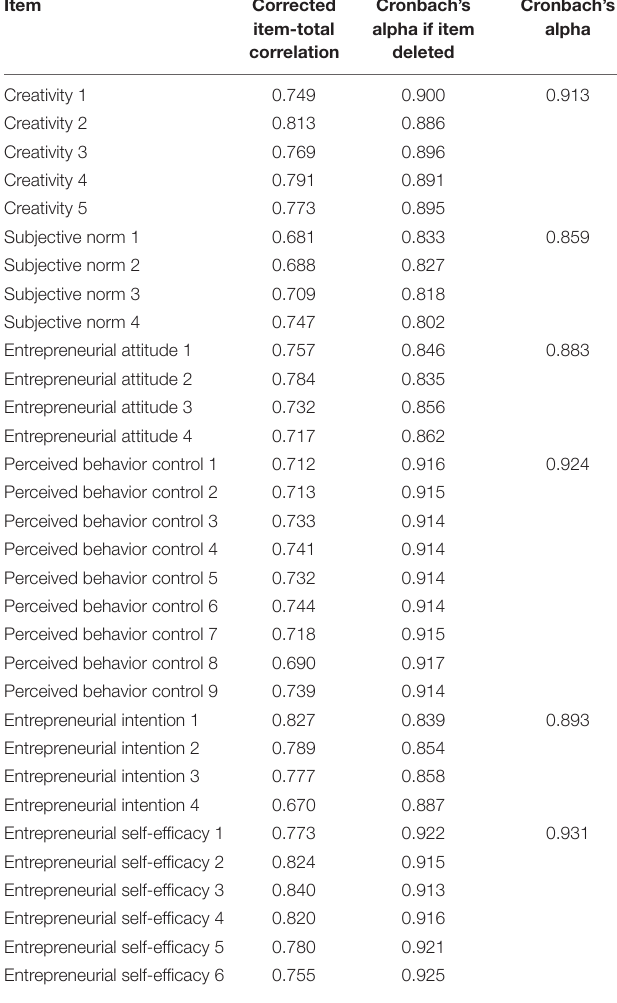
TABLE 1 | Reliability analysis